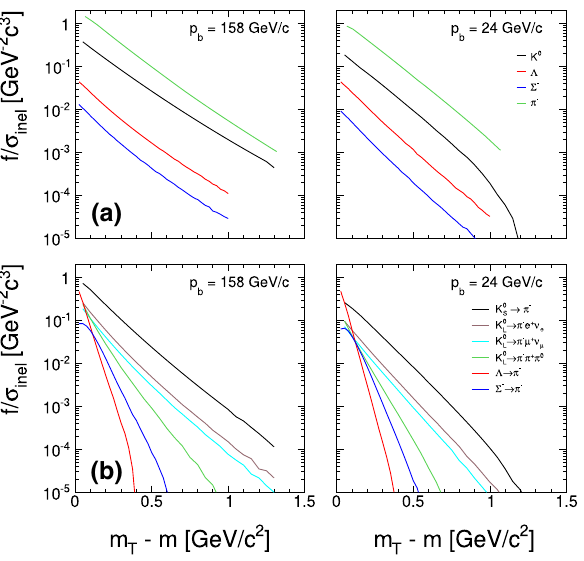
NA49 pp/pA group [75]. A sub-sample is shown as Table 5 for six values of log ( s ) as functions of y lab and p T .